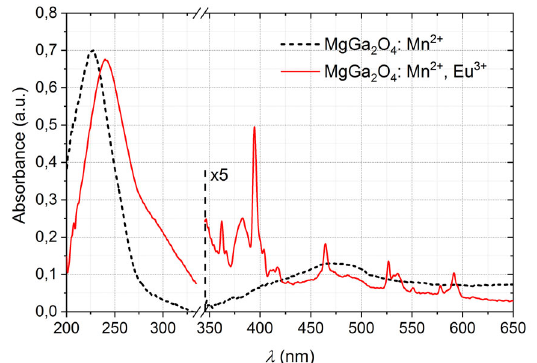
Fig. 6 Optical absorption spectra of spinel-structured MgGa 2 O 4 ceramics activated with Mn 2+ ions and co-doped with Mn 2+ and Eu 3+ ions (the long-wavelength part of the absorption signal is 5 times scaled).